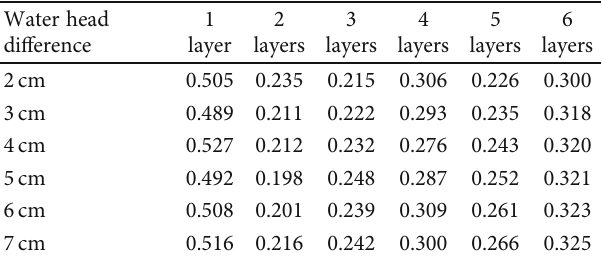
Figure 7: Schematic diagram before adding tailing Table 2: Permeability coe ffi cient K of the slotted tube overlay geotextile.